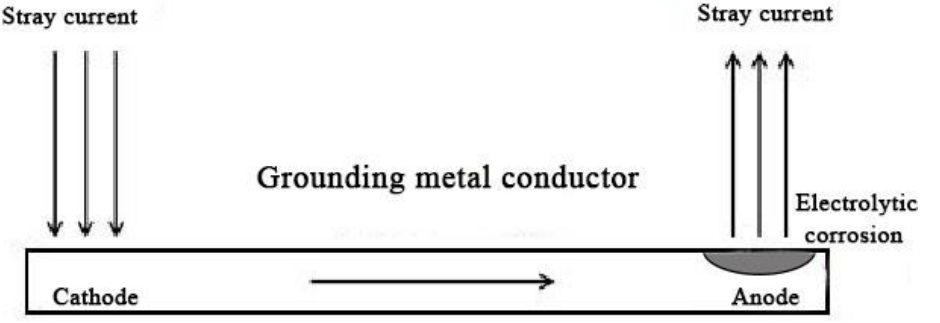
Figure 5. DC stray current corrosion mechanism.